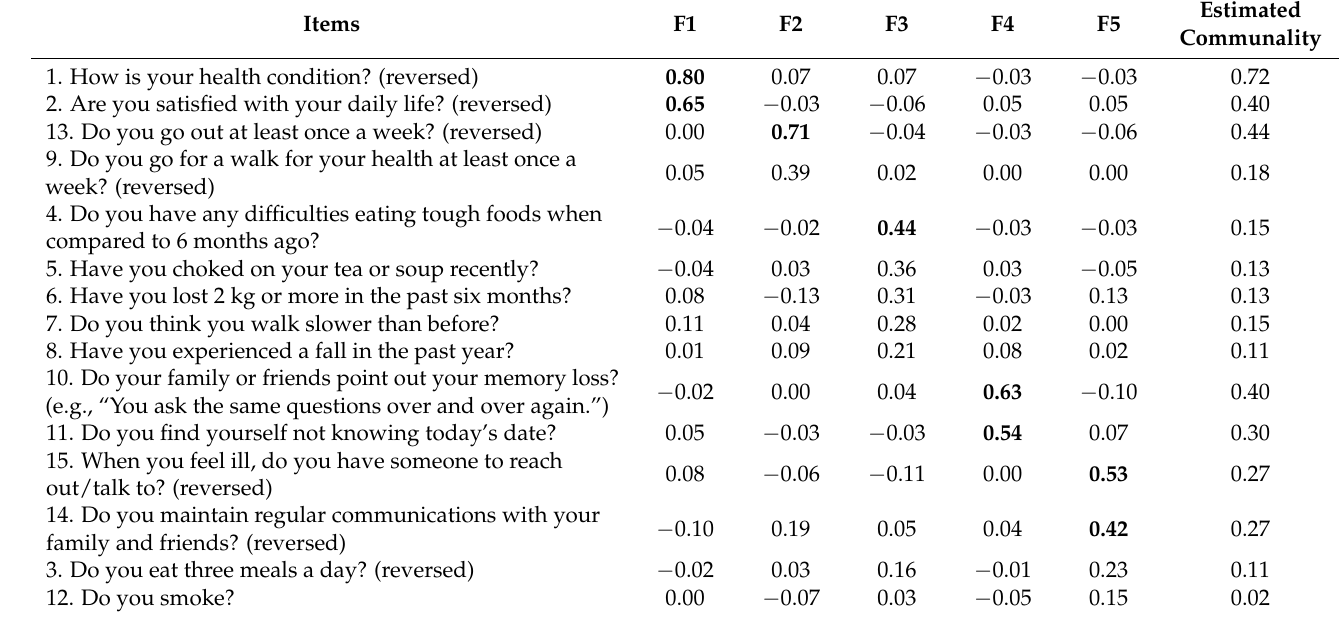
Table 4. Factor loadings and estimated communality in the EFA using the principal factor method with Promax rotation of the health assessment questionnaire for old-old adults (15